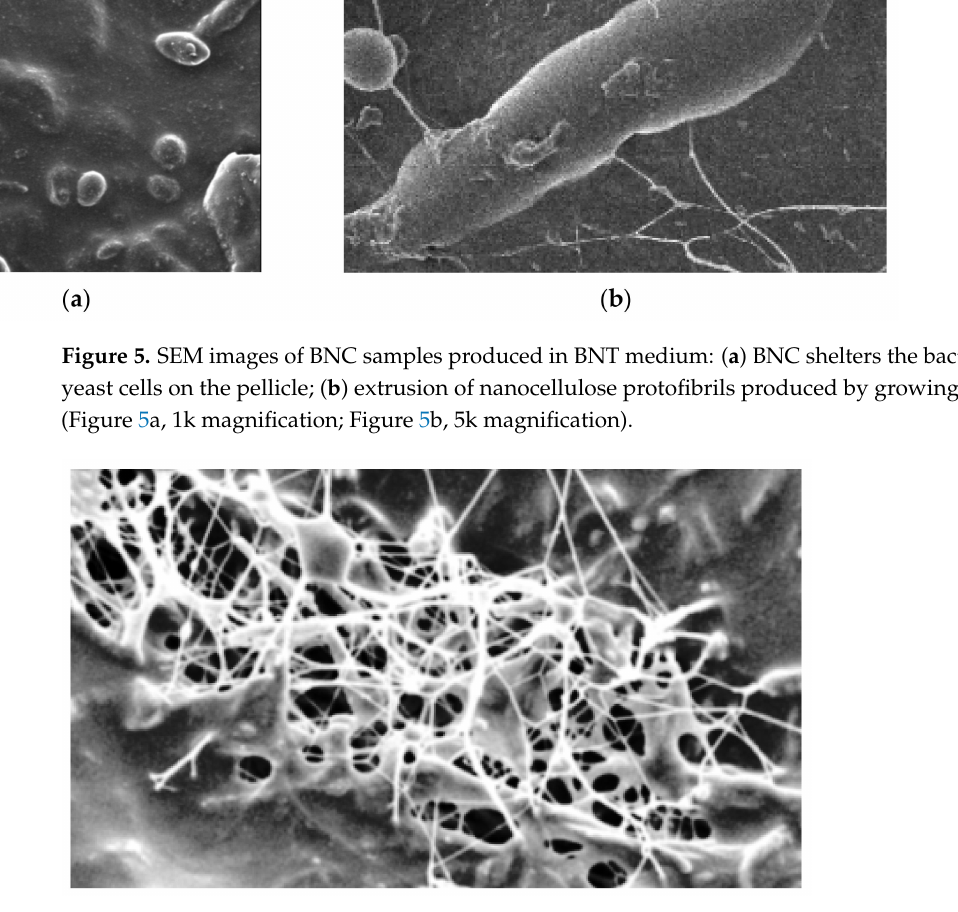
Figure 6. SEM image of BNC sample produced in BTR medium (10k magnification).